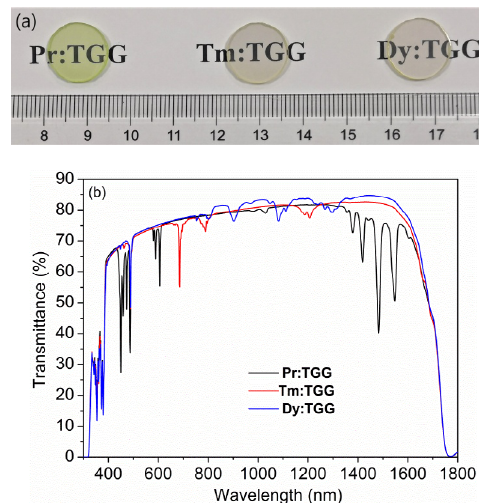
Fig. 3 Photograph and in-line transmission curves of the 1.0 at% RE:TGG ceramics pre-sintered at 1500 ℃ for 3 h in air and HIP-ed at 1500 ℃ for 3 h.